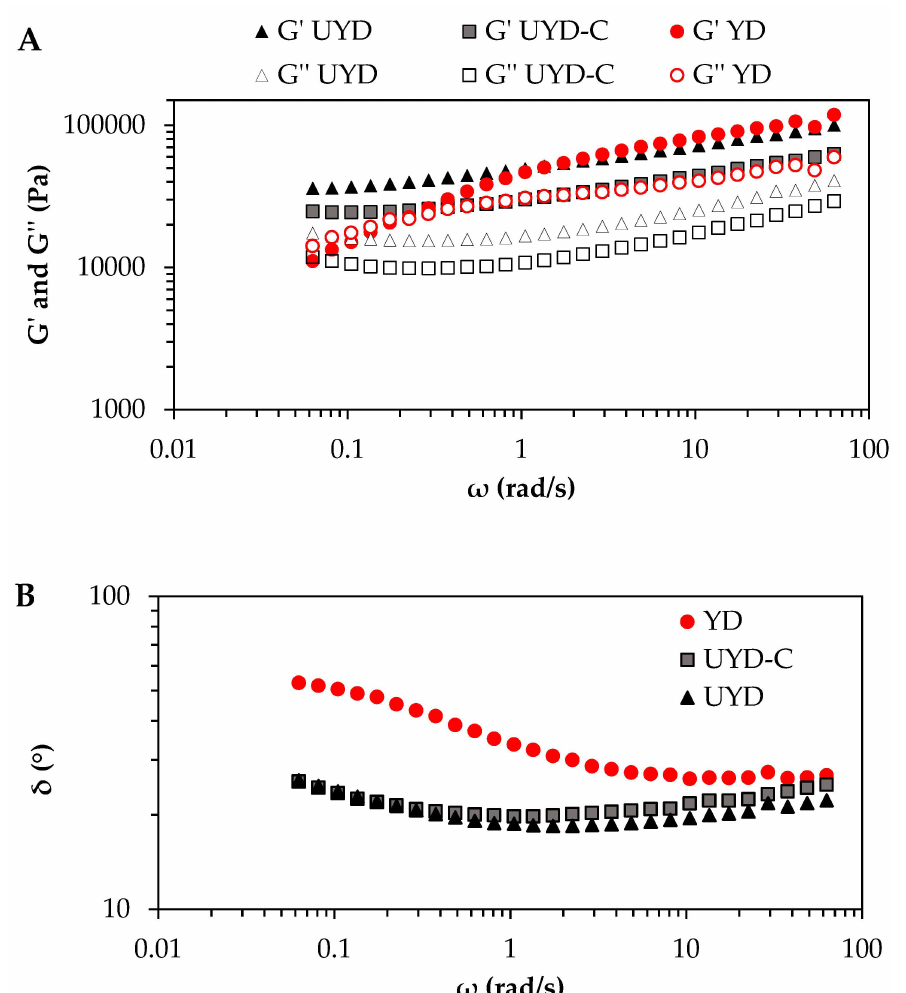
Figure 1. ( A ) Mechanical spectra as a function of the elastic ( G (cid:48) ) and viscous ( G ”) parameters and ( B ) mechanical spectra as a function of phase angle ( δ ) of unyeasted wheat dough (UYD), yeasted wheat dough (YD) and CH-rich unyeasted wheat dough (UYD-C). T = 25 ◦ C. Empirical data are mean values of 7